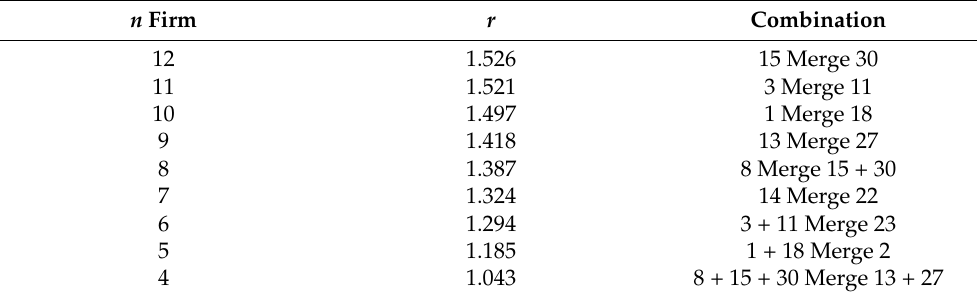
Table 6. Optimal market structure and configuration.